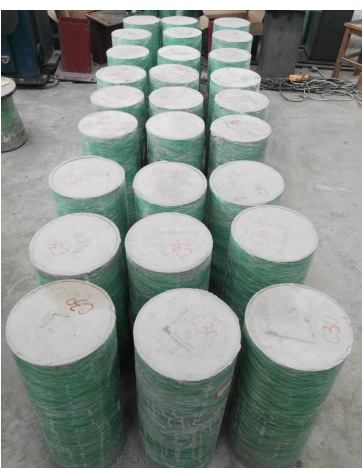
age value of elastic modulus for the angle section steel is